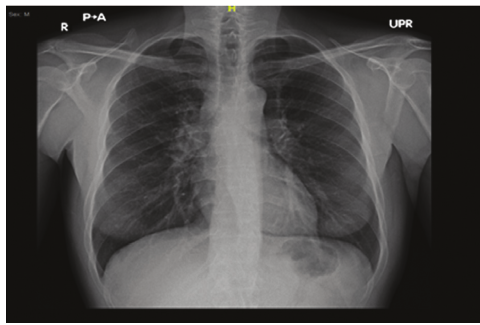
Figure 1: Chest X-ray showing bilateral hilar lymphadenopathy.